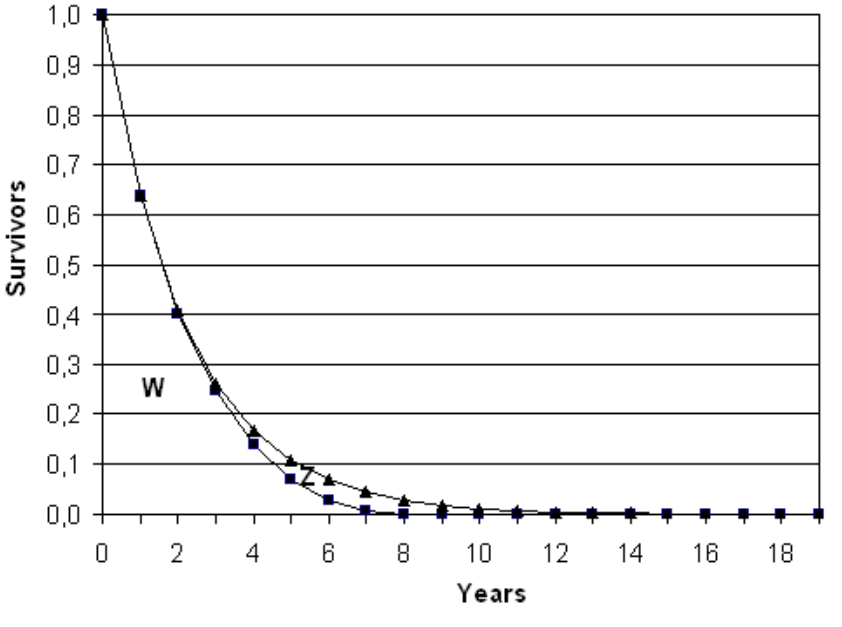
FIGURE 5. Life table of Parus atricapillus (MF) with ( ■ ) and without ( ▲ ) intrinsic mortality. With high extrinsic mortality area Z is